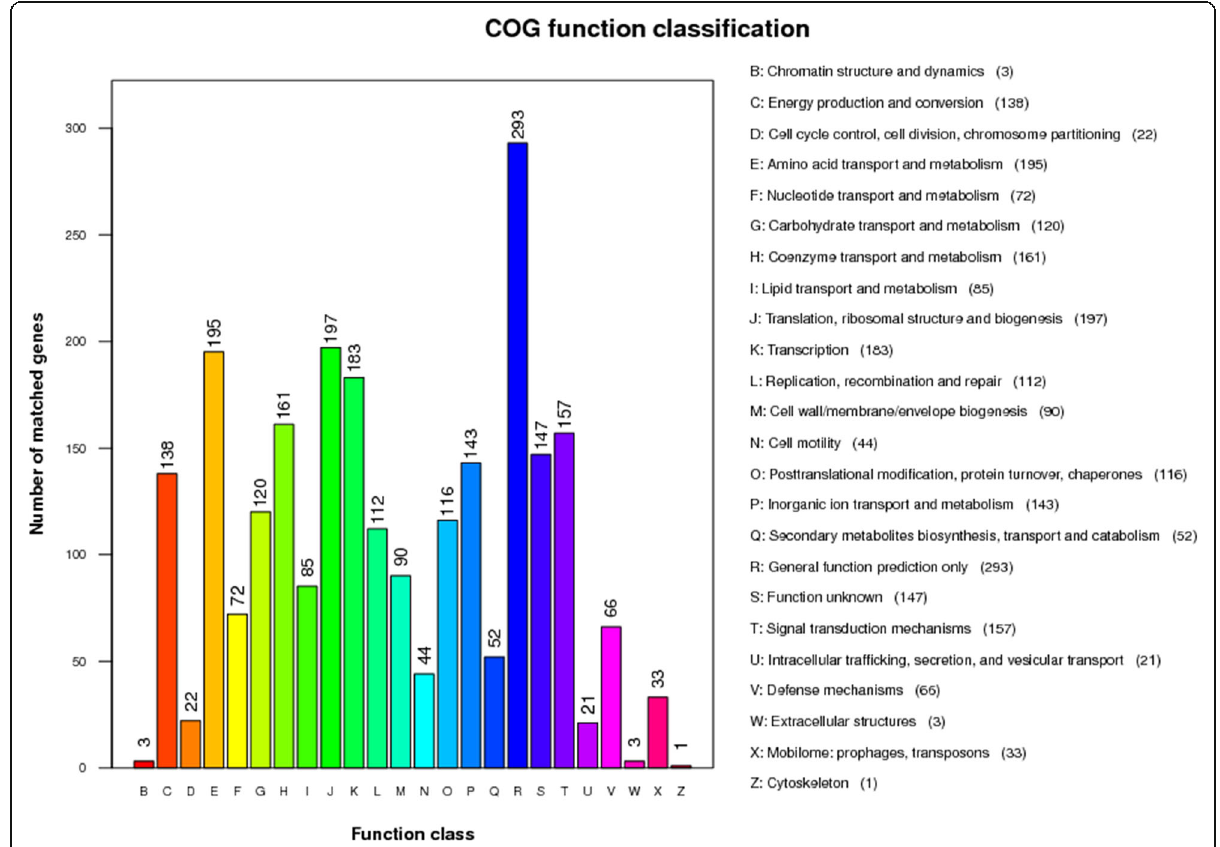
Fig. 3 COG categories of coding proteins, x -axis indicates the function classes and y -axis indicates the number of the predicted proteins in Halomicrobium sp.